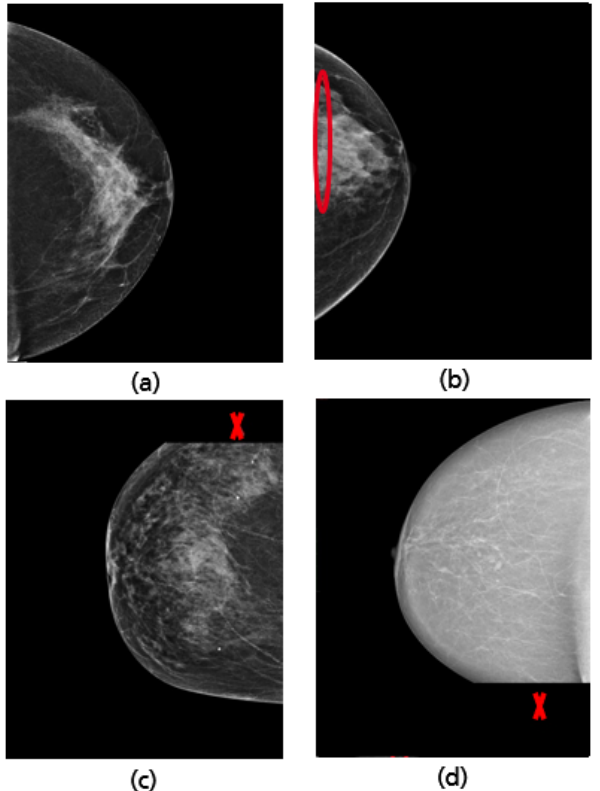
Figure 30. Examples of well-positioned ( a ) and inadequately positioned CC views: retromammary tissue not fully visualized ( b ), missing part of the axillary tail ( c ), and missing part in the lower breast quadrant ( d ).